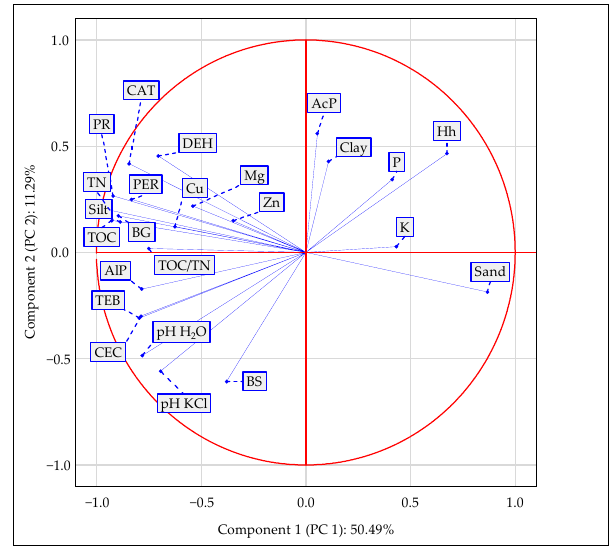
Figure 3. Principal component analysis soil properties’ plot of the first two principal components (PC) for the measured soil properties. Sand, Silt, Clay, Hh—hydrolytic acidity, TEB—total exchangeable bases, CEC—cation exchange capacity, BS—degree of saturation of the sorptive complex with base cations (%), TOC—total organic carbon, TN—total nitrogen, P—available